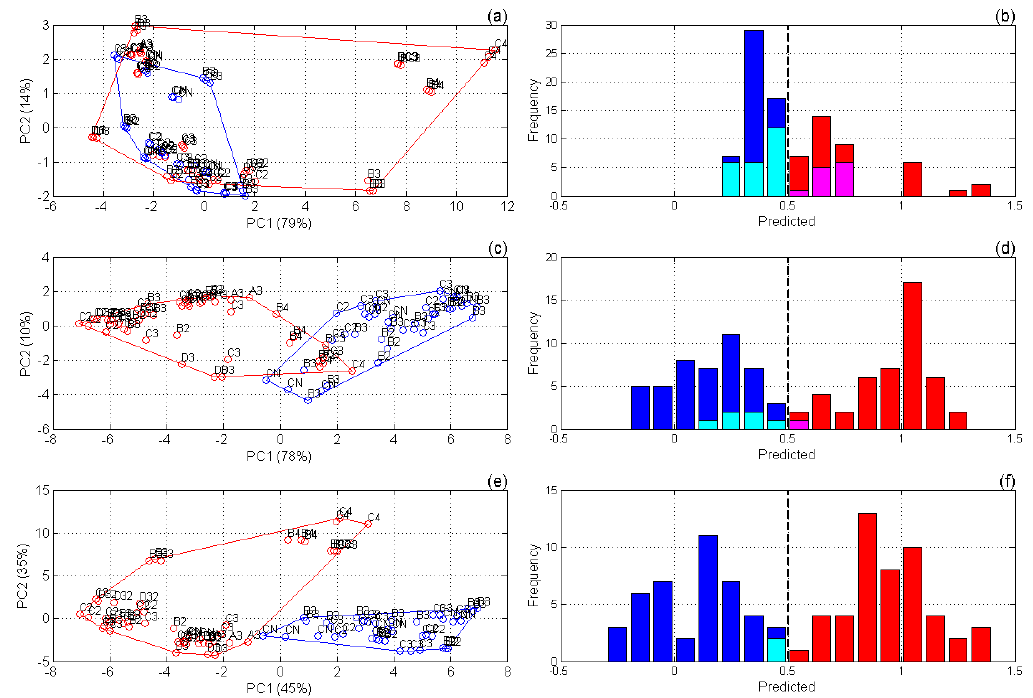
Figure 4. Principal component analysis (PCA) and partial least-squares discriminant analysis (PLS-DA) models (segmented cross-validation results): ( a , c , e ) score plots of PCA models and ( b , d , f ) frequency histograms of PLS-DA-predicted values for: ( a , b ) fluorescence spectra corrected by standard normal variate (SNV), ( c , d ) SNV-corrected second derivative MIR spectra, and ( e , f ) concatenated dataset. In ( a , c , e ): red and blue colors designate tumor and normal tissue samples, respectively; labels designate measurement positions on the sample; percent variances explained by the corresponding principal components are shown in brackets on the axis labels. In ( b , d , f ): blue, cyan, red, and magenta colors designate true negatives ( TN ), false negatives ( FN ), true positives ( TP ), and false positives ( FP ), respectively.